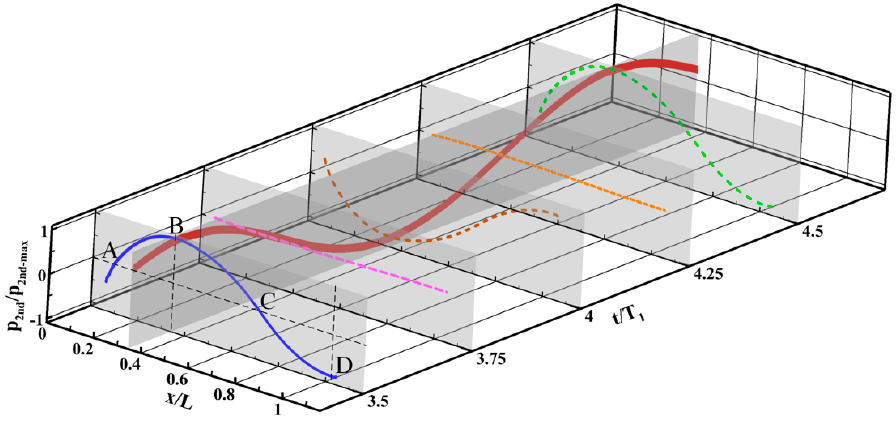
Figure 13. Transient static pressure characteristic along the internal flowpath during one buzz cycle.